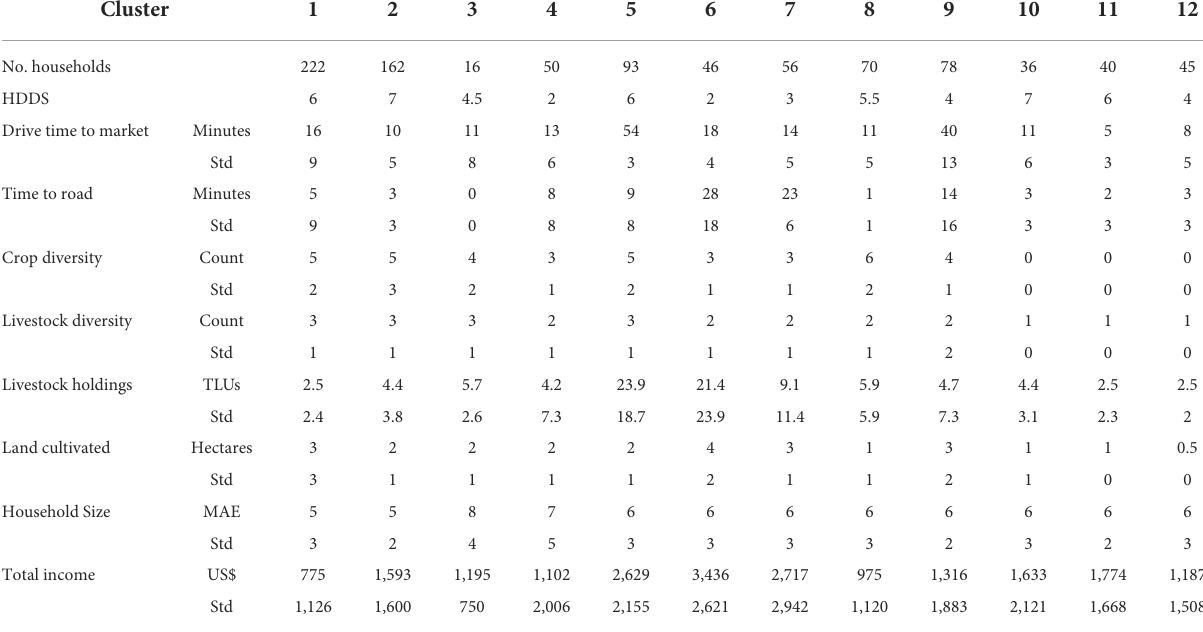
TABLE 1 Descriptive statistics for the main study variables for the 12